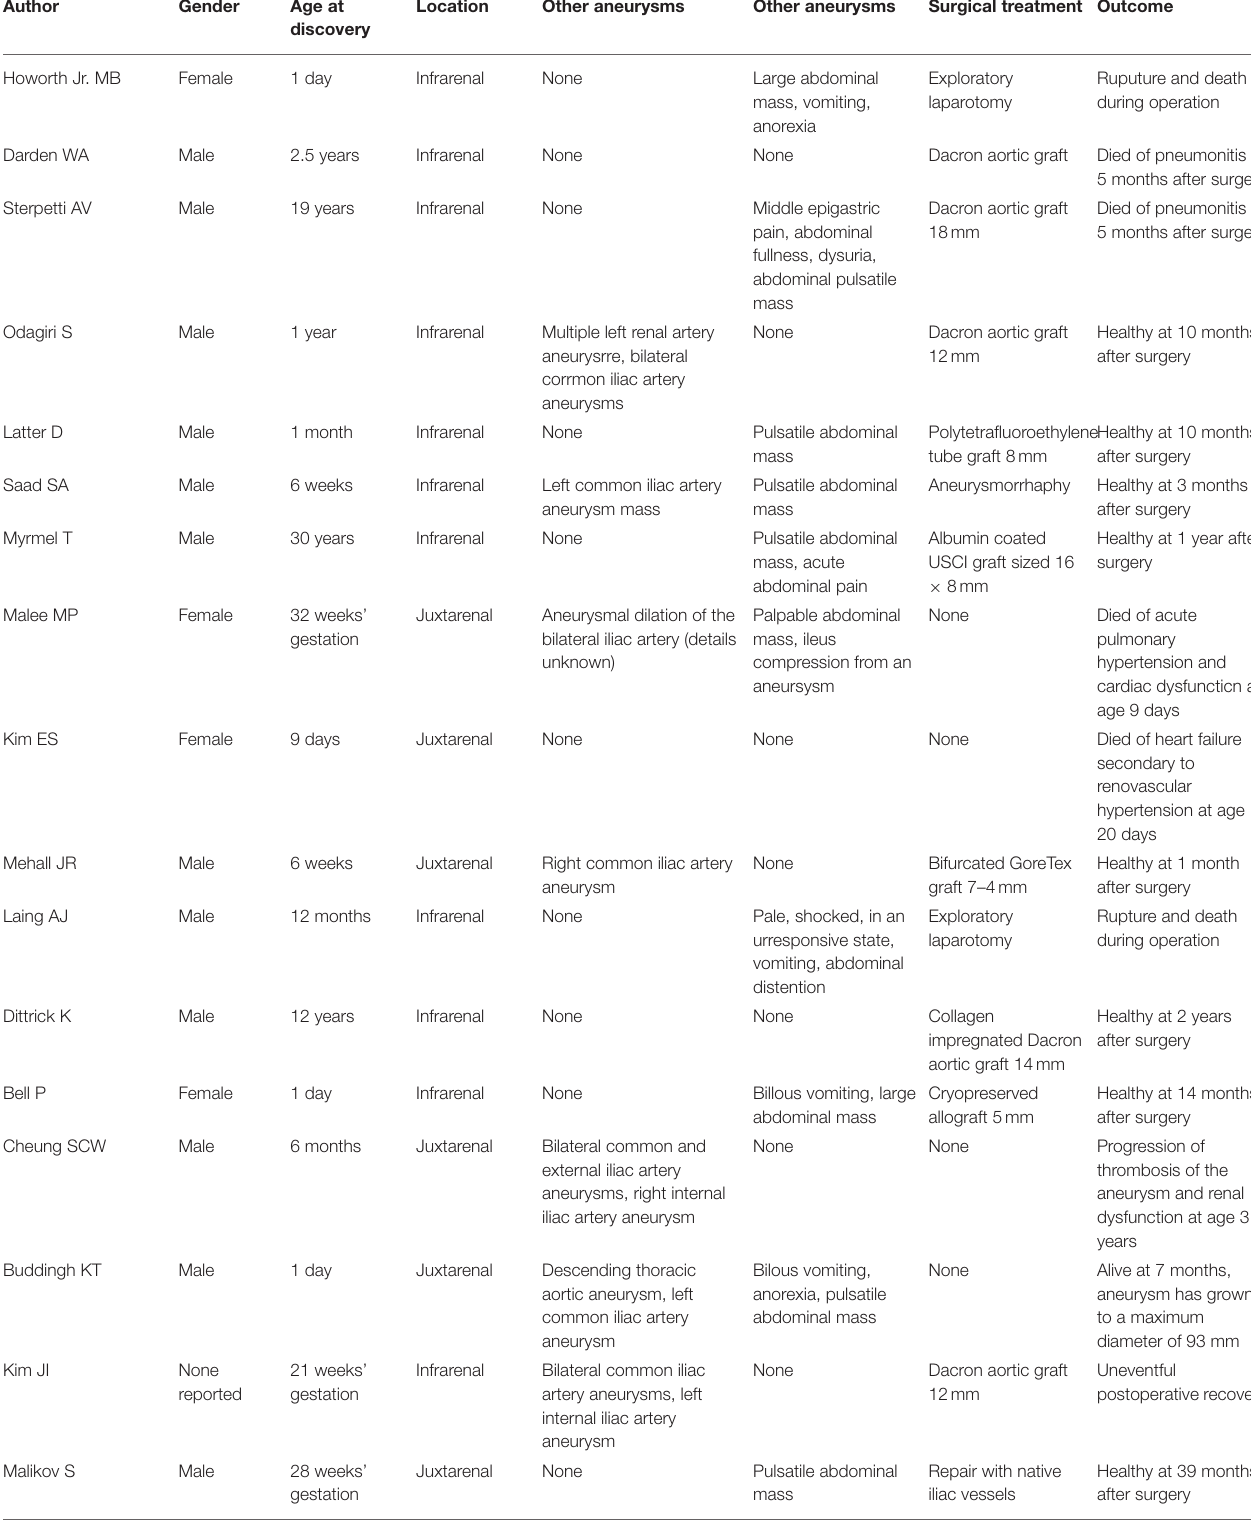
TABLE 1 | Previously reported cases of idiopathic congenital abdominal aortic aneurysms. Author